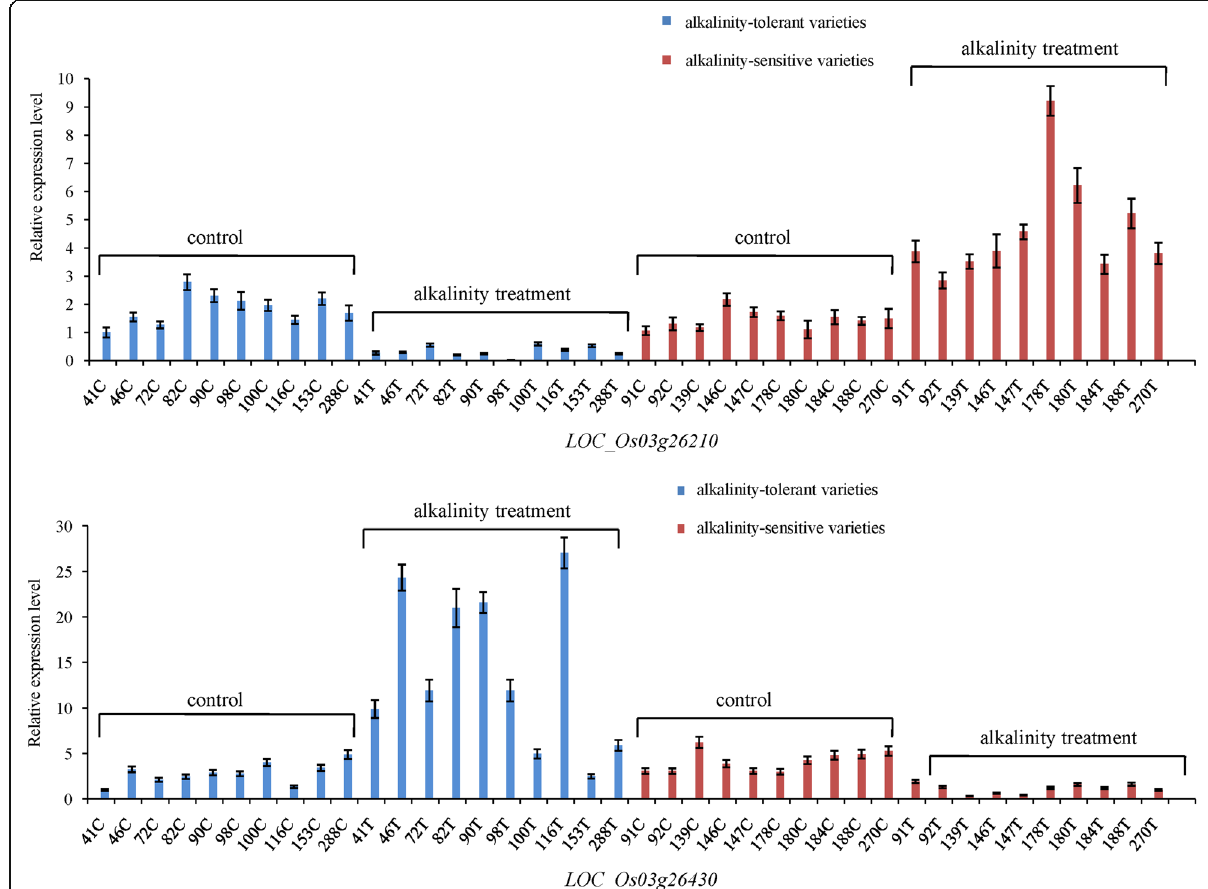
Fig. 5 Expression patterns of LOC_Os03g26210 and LOC_Os03g26430 under normal growth conditions and alkalinity stress conditions. C indicates normal growth conditions, T indicates alkalinity stress conditions. The number preceding C and T indicates the number of rice